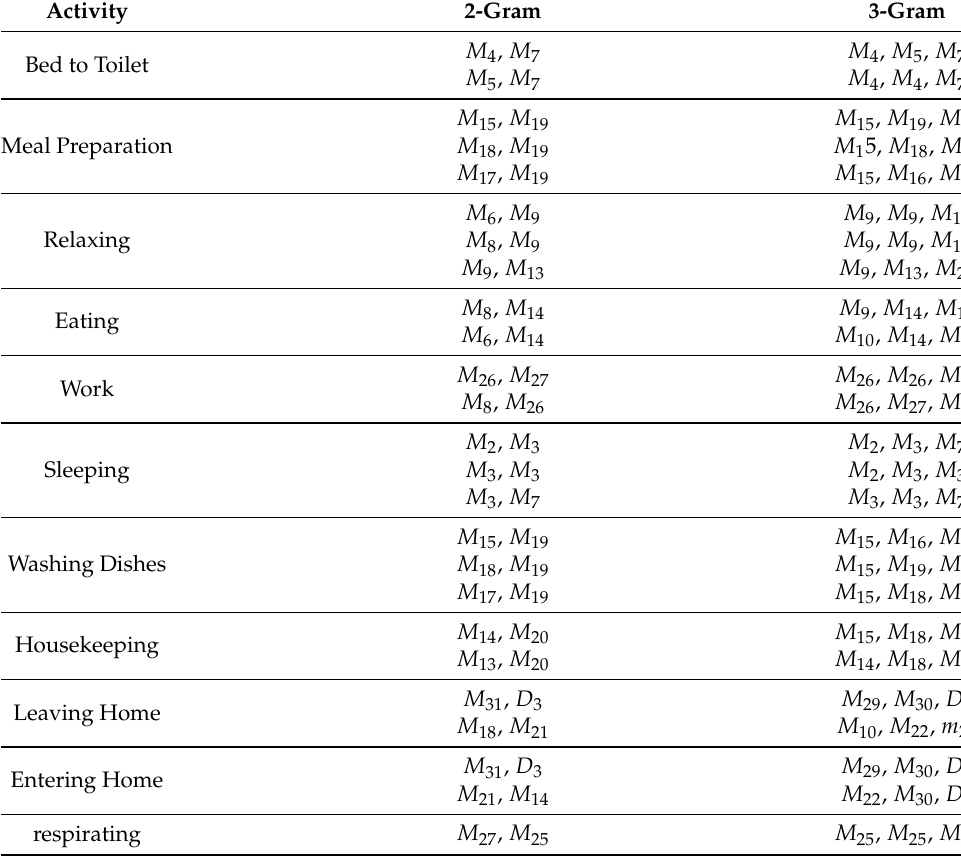
Table 3. N-gram patterns extracted from training